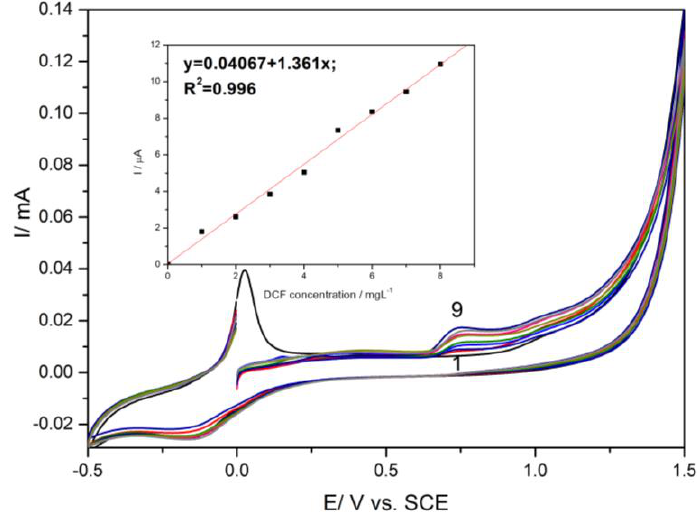
Figure 2. Cyclic voltammogram recorded on HKUST-CNF electrode in 0.1 M Na 2 SO 4 supporting electrolyte (curve 1) and in the presence of various DCF concentrations: curves 2–9: 1–8 mg·L −1 DCF; potential scan rate: 0.05 V·s −1 ; potential range: −0.5 to +1.5 V/SCE. Inset: Calibration plots of the currents recorded at E = +0.75 V vs. SCE vs. DCF concentrations.